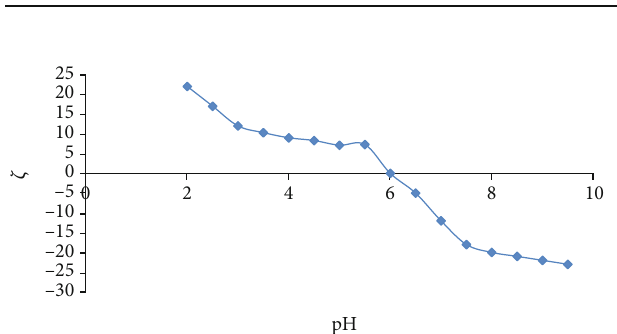
Figure 6: Zeta potential ( ζ ) of WPE/PAMK-TFN membrane against pH using 1 mMKCl